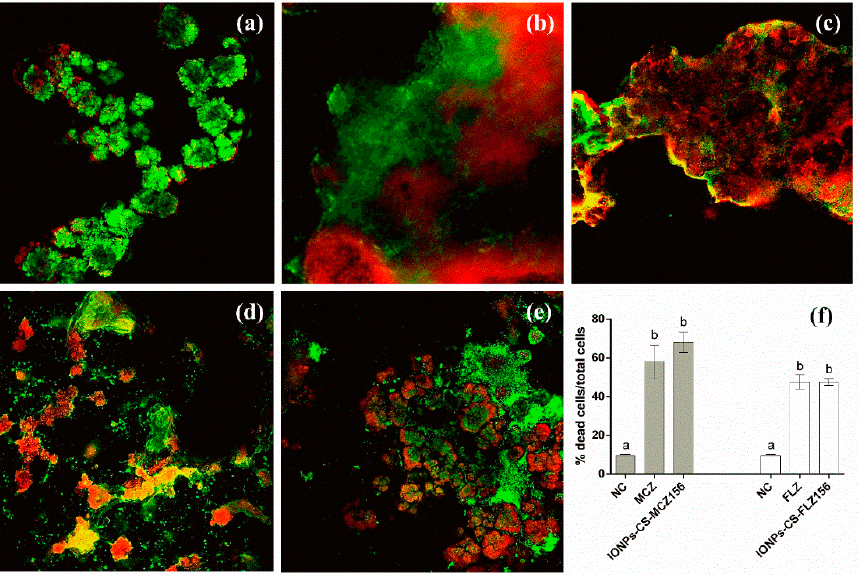
Figure 3. Confocal laser scanning microscopy images of 96-h microcosm biofilms treated during 24 h with miconazole (MCZ) at 156 µg/mL ( b ), chitosan (CS)-coated iron oxide nanoparticles (IONPs) carrying MCZ at 156 µg/mL ( c ), fluconazole (FLZ) at 156 µg/mL ( d ), and FLZ-containing nanocarrier at 156 µg/mL ( e ). The negative control ( a ) represents the biofilm formed for 120 h with pure culture medium. Red and green fluorescence indicate dead and living cells, respectively. Magnification: 20 × . The image ( f ) represents the percentage of dead cells in relation to the total cells, and different lowercase letters represent significant differences among the groups (one-way ANOVA and Fisher LSD’s test; p < 0.05). Comparisons were performed separately for each antifungal, its respective nanocarrier and negative